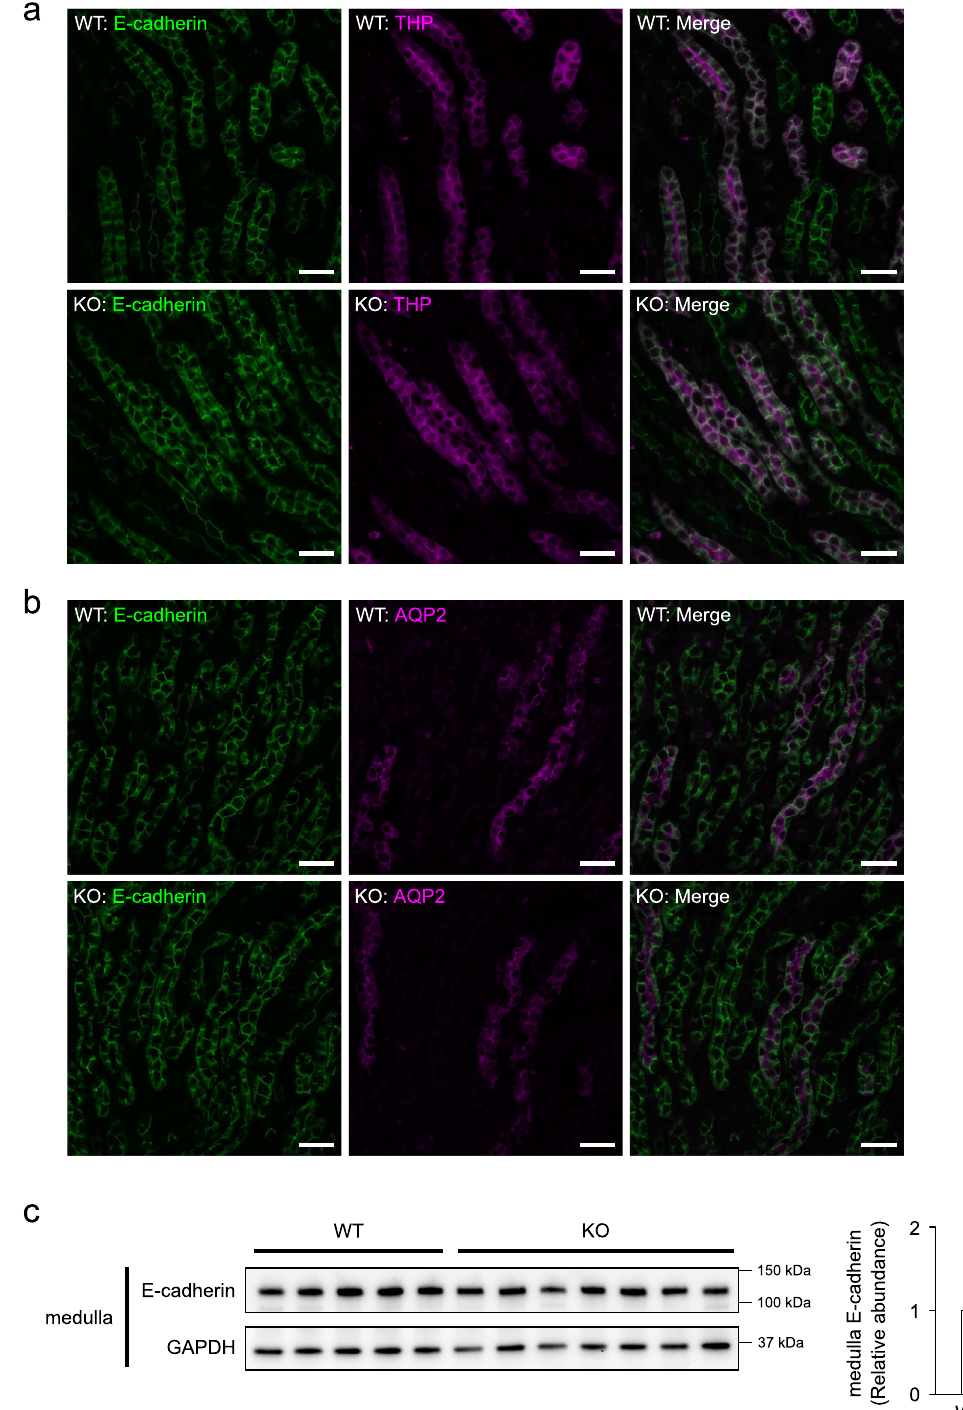
Figure 7. E-cadherin expression in the renal medulla of WT and KO mice at P14. ( a, b ) Immunofluorescent staining of E-cadherin (green) with counterstaining of Tamm-Horsfall protein (THP) (magenta) for thick ascending limbs of loop of Henle ( a ) and AQP2 (magenta) for collecting ducts ( b ) in the renal medulla at P14. Scale bars, 50 μm. ( c ) Immunoblots and quantities of E-cadherin in the renal medulla at P14 (n = 5–7 per group). The expression was normalized to a loading control (GAPDH) and reported relative to the WT group. Data are expressed as mean ± SEM. Statistical significance was analyzed by unpaired t test. N.S.: not